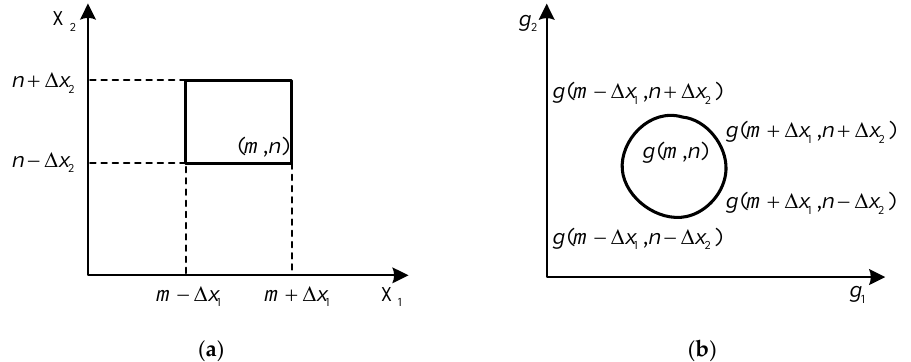
Figure 4. The relationship of design parameters and function range: ( a ) design parameter range; ( b ) function